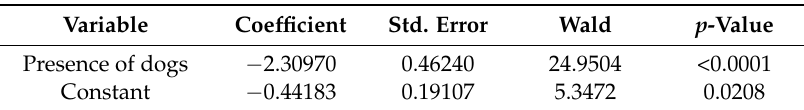
Table 1. Coefficients and Standard Errors in estimated logistic regression model of the human exposure rate on the presence of dogs.